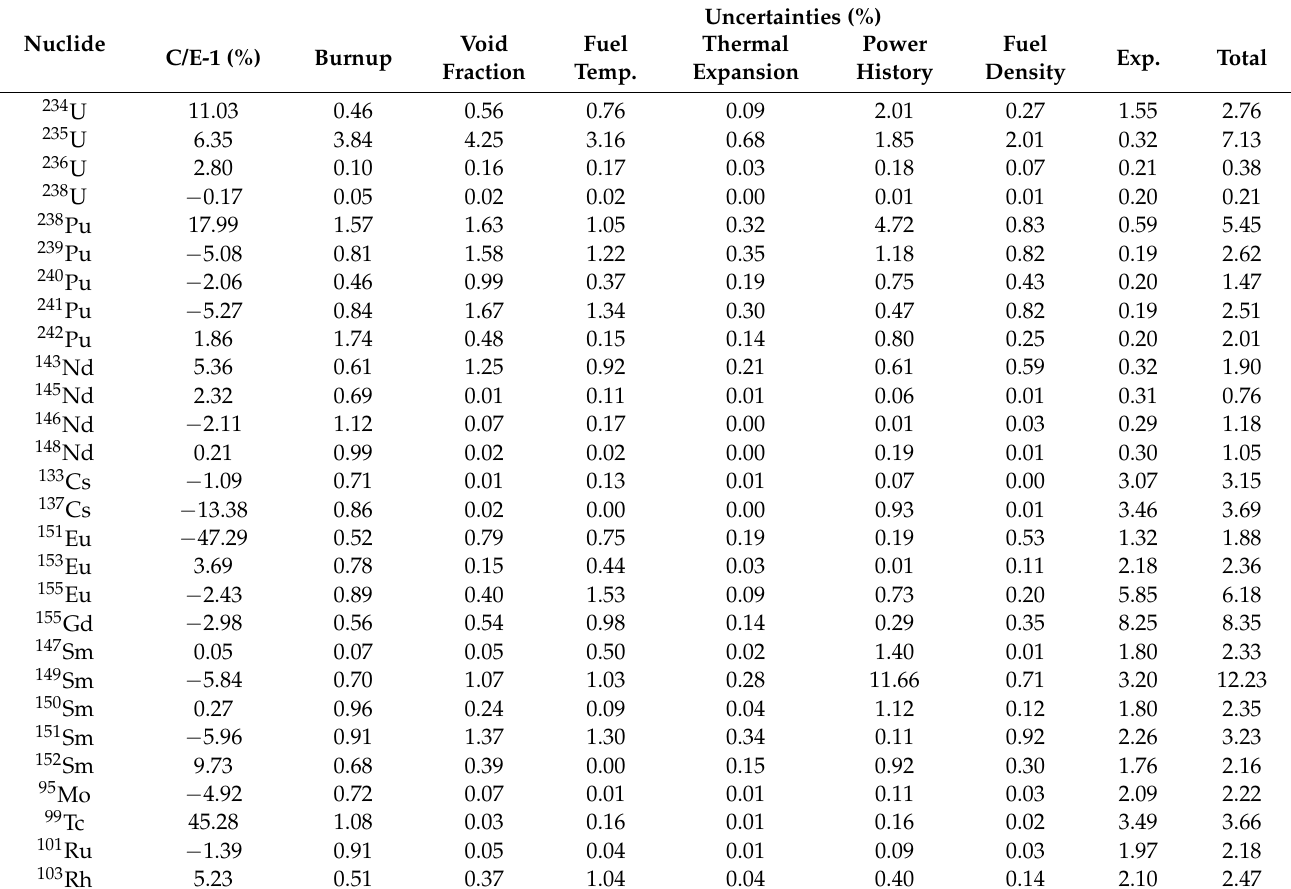
Table 4. C/E-1 (%) and uncertainties for sample 2F1ZN3-C2-GdM (57.7 GWd/MTU).